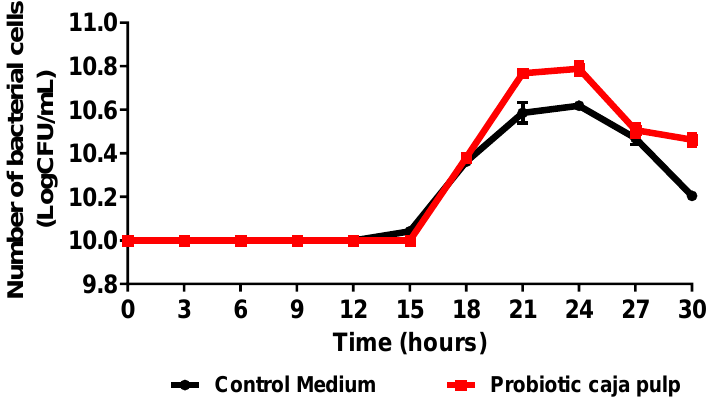
Figure 1. Time course of the number of viable cells during the Bifidobacterium animalis ssp. lactis B94 fermentation in caja pulp and the control medium (MRS broth).